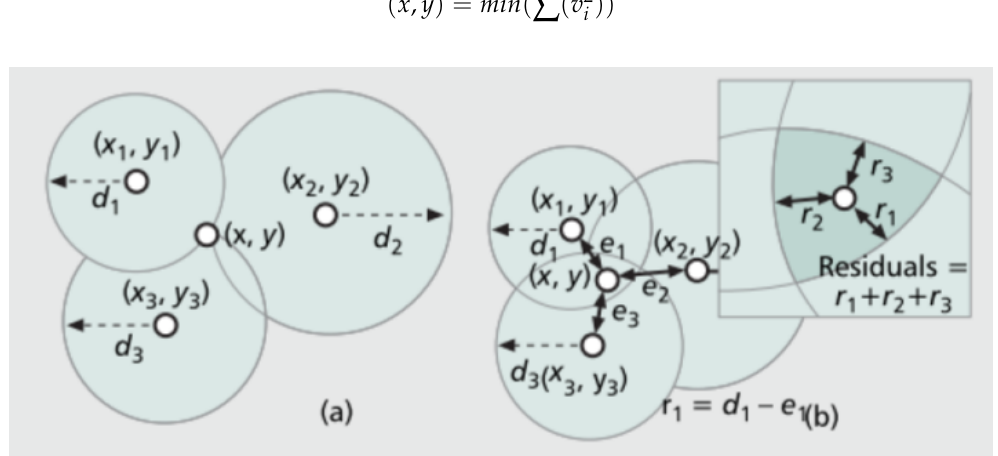
Figure 1. Schematic example of trilateration as in [11]. ( a ) illustrates the normal trilateration process of calculating a node’s position with the help of the intersection of three circles. ( b ) illustrates the real-world scenario where the circles do not intersect precisely at one position but at many positions due to inaccurate position information, which makes estimating a node’s position very